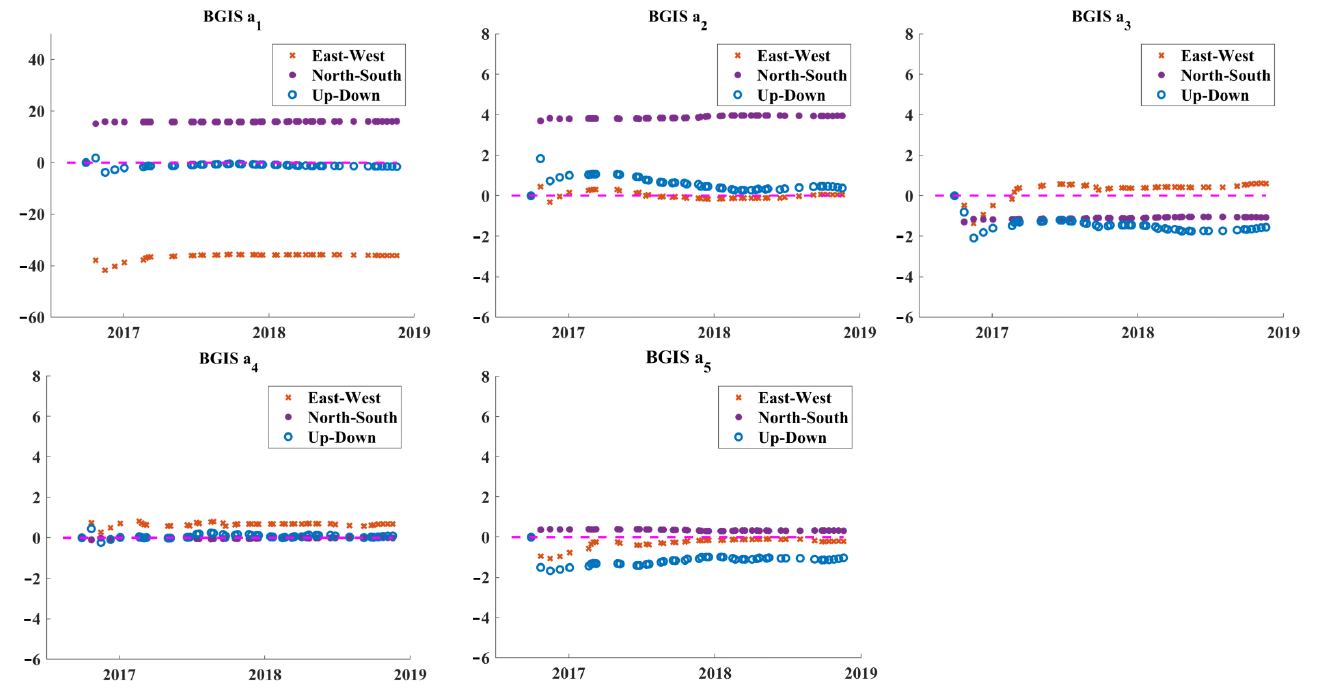
Figure 14. The five fitting coefficients of SM-Kalman (2PI+4PI) vary with the observation